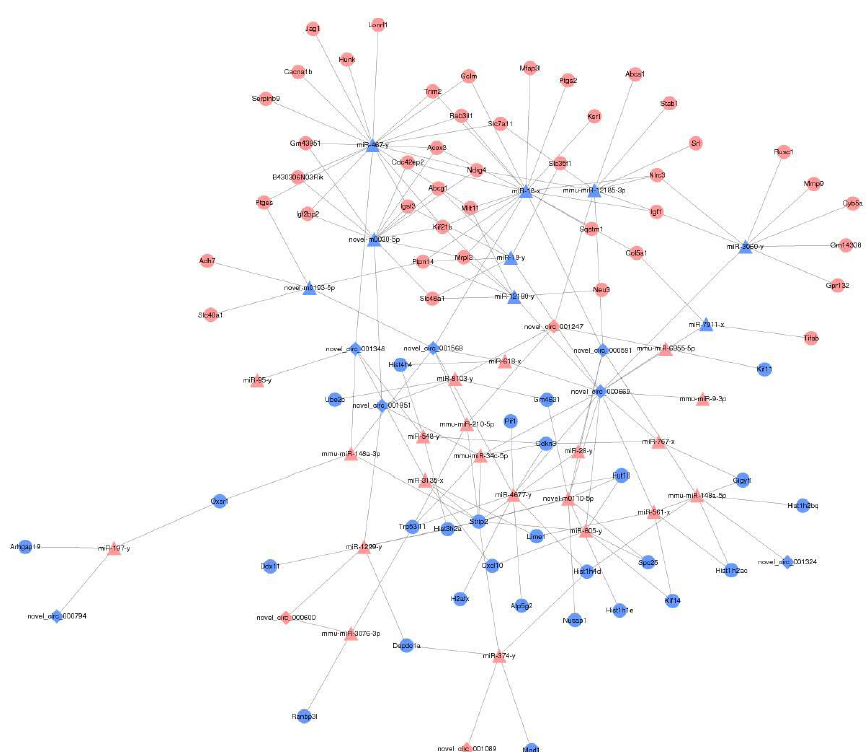
Figure 9. The regulation network of PAP-1 on circRNA-miRNA-mRNA in PRV-infected RAW264.7 cells. The up-regulated mRNA was represented as a red circle, while the down-regulated mRNA was represented as a blue circle. The up-regulated circRNA was represented by a red diamond, while the down-regulated circRNA was represented by a blue diamond. The up-regulated miRNA is represented by a red triangle, while the down-regulated miRNA is represented by a blue triangle. Sequence targeting relationships between miRNA and other RNA analyses are shown in black lines.